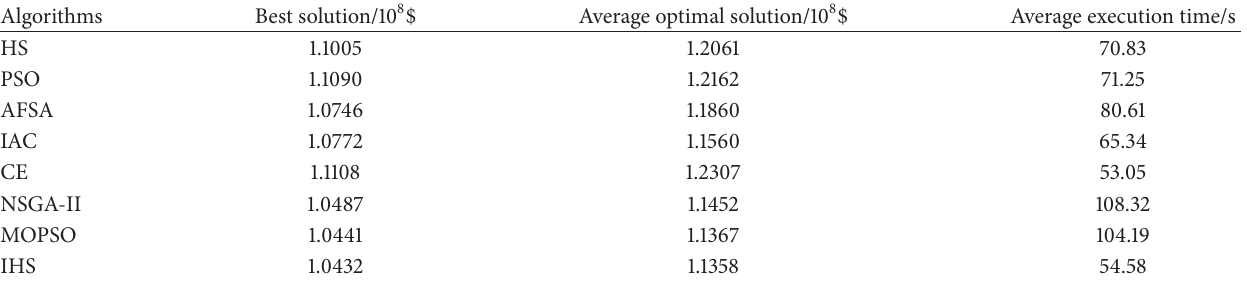
Table 3: The comparison results of distribution network planning for some optimization